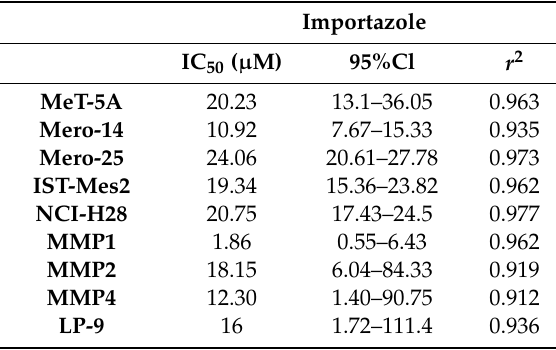
values, for each cell line, are reported with 95% confidence interval, and the computed r 2 for nonlinear